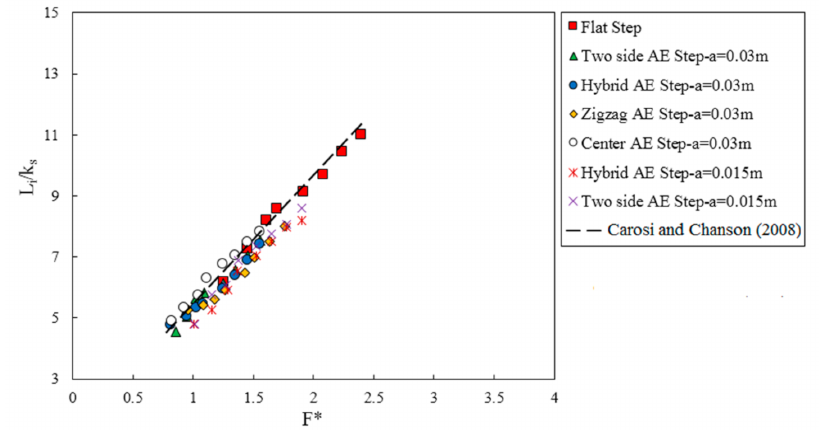
Figure 21. Inception points of free-surface aeration for flat step and appendance elements on step of stepped